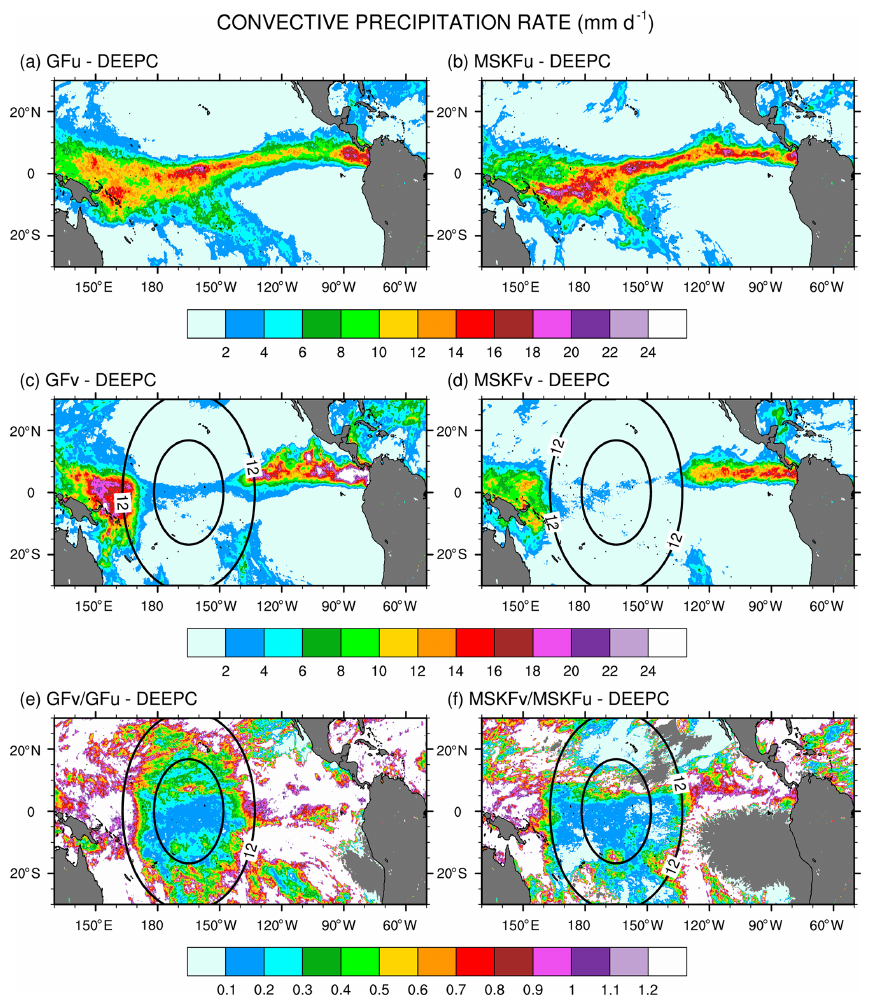
Figure 8. Monthly-mean convective (DEEPC) precipitation rate over the tropical Pacific Ocean simulated in (a, b) GFu and MSKFu and (c, d) GFv and MSKFv and ratio between the monthly-mean convective precipitation rate in (e, f) GFv (MSKFv) and GFu (MSKFu) for December